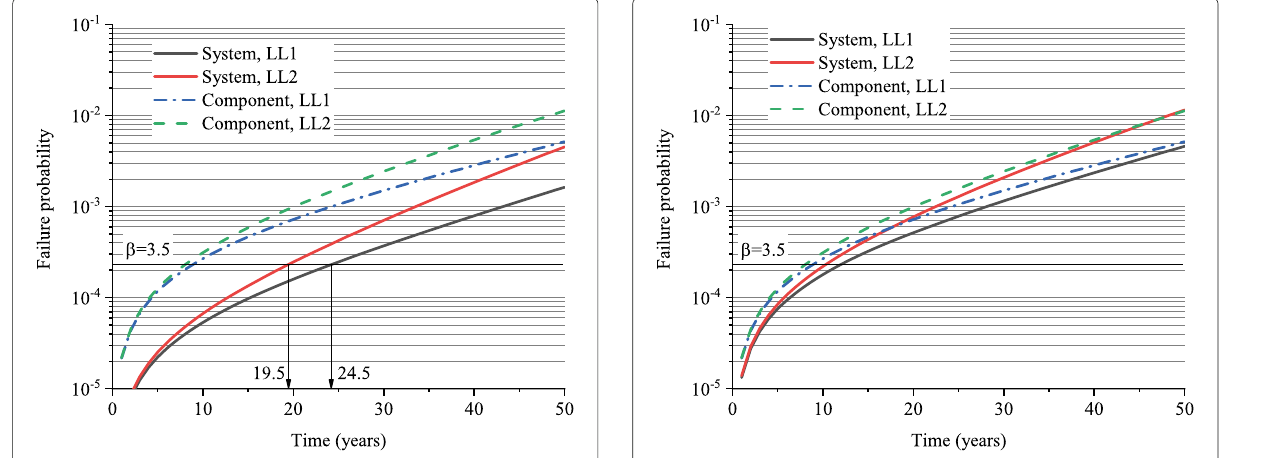
Fig. 1 Time-dependent failure probabilities of a 3-out-of-5 system and a single component